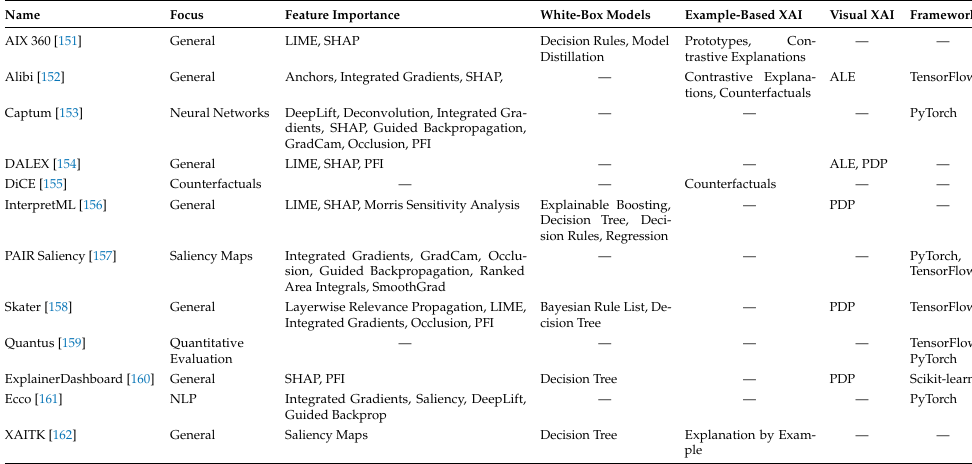
Table 2. Overview of popular XAI